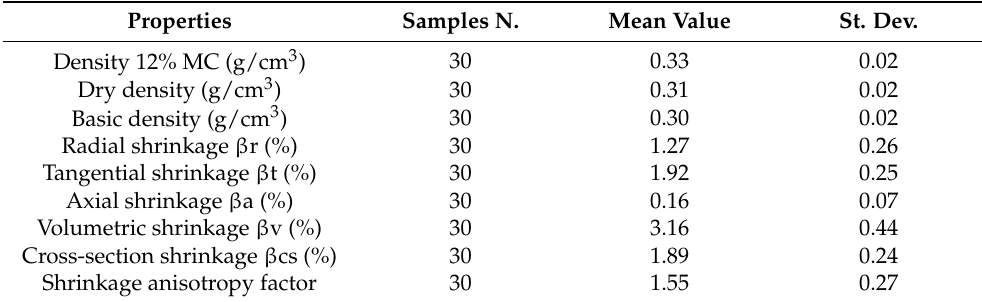
Table 1. Physical properties of heat-treated ayous wood.